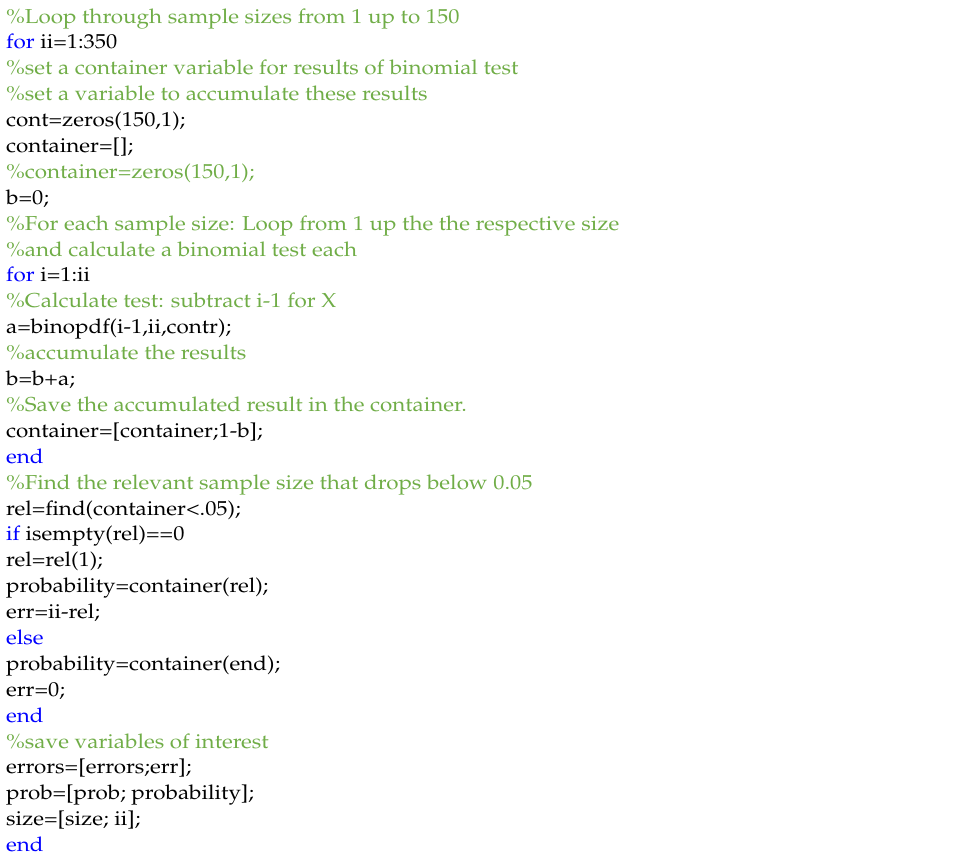
Algorithm 1. Calculation of error